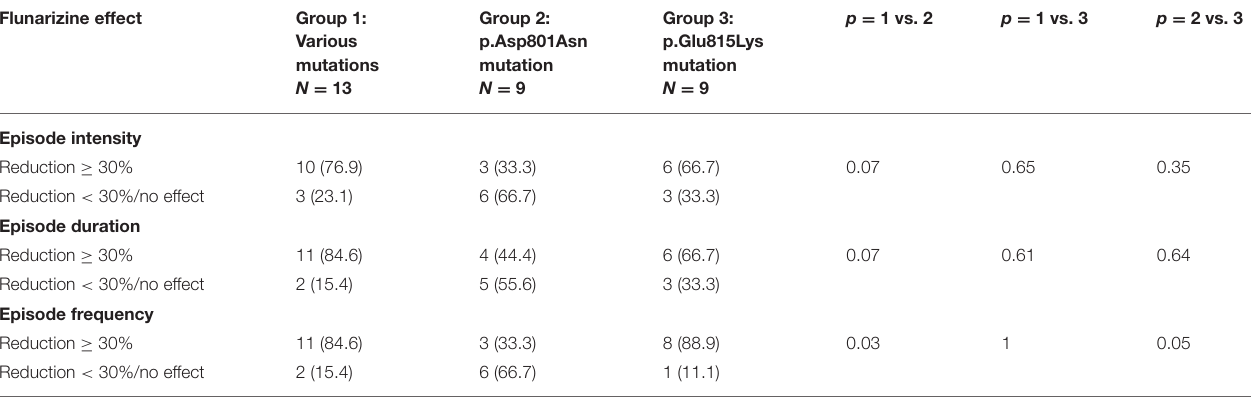
TABLE 3 | Flunarizine effect in the three mutational groups. Flunarizine